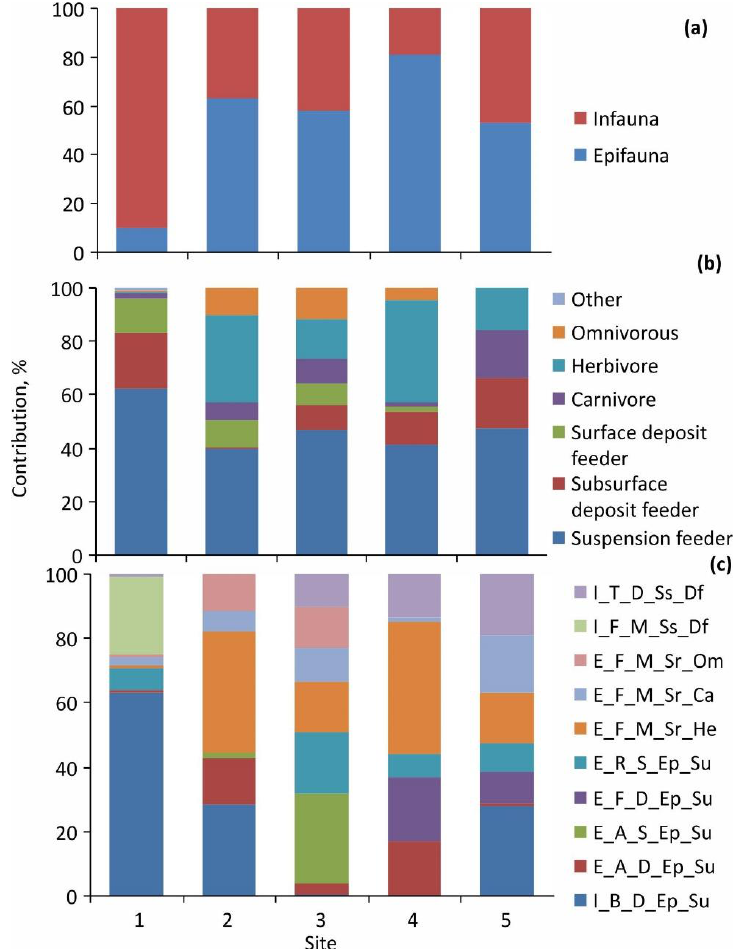
Figure 4. Contribution of benthic organisms to the diet of red king crabs in Kola Bay: ( a ) — living forms; ( b ) — trophic groups; ( c ) — functional groups; I_B_D_Ep_Su — Infaunal burrowing